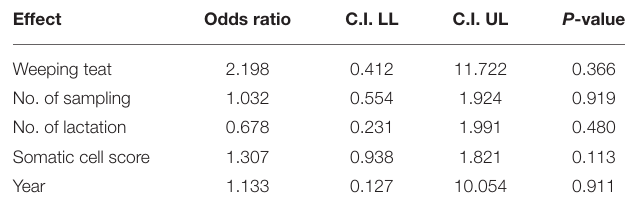
TABLE 5 | Results of the linear general mix model on herd A sampled in 2019 on fixed effects in Model 2. Effect Odds ratio